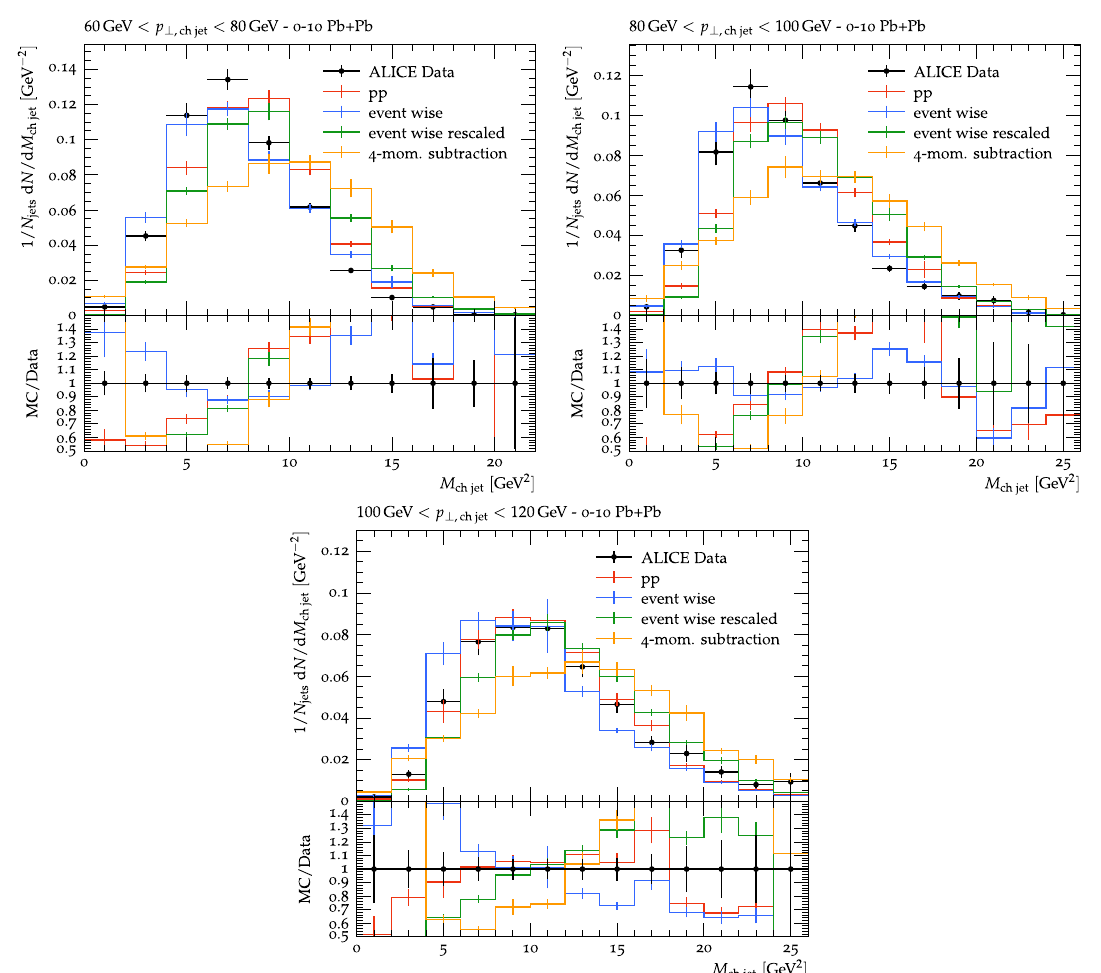
Fig. 4 Charged jet mass measured by ALICE [75] ( R = 0 . 4, | η ( jet ) | < 0 . 5) with different versions of constituent and four-momentum subtraction. See text for